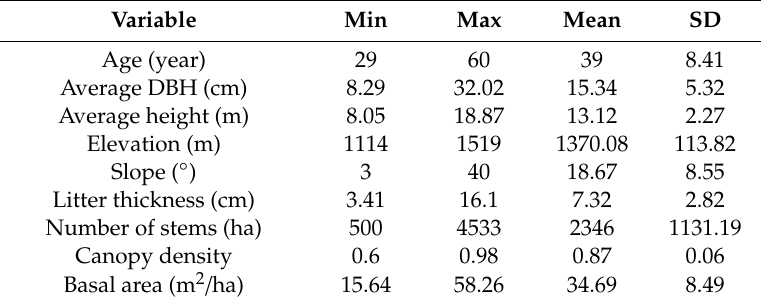
Table 2. Analysis of survey